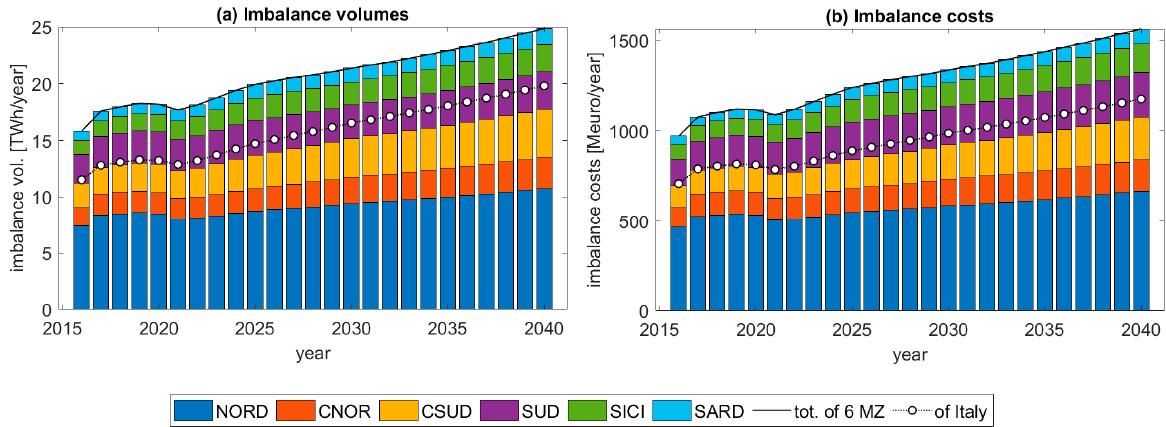
Figure 15. Current and future imbalance volumes and costs under the TSO’s demand/VRE capacity growth scenario. ( a ) Imbalance volumes. ( b ) Imbalance